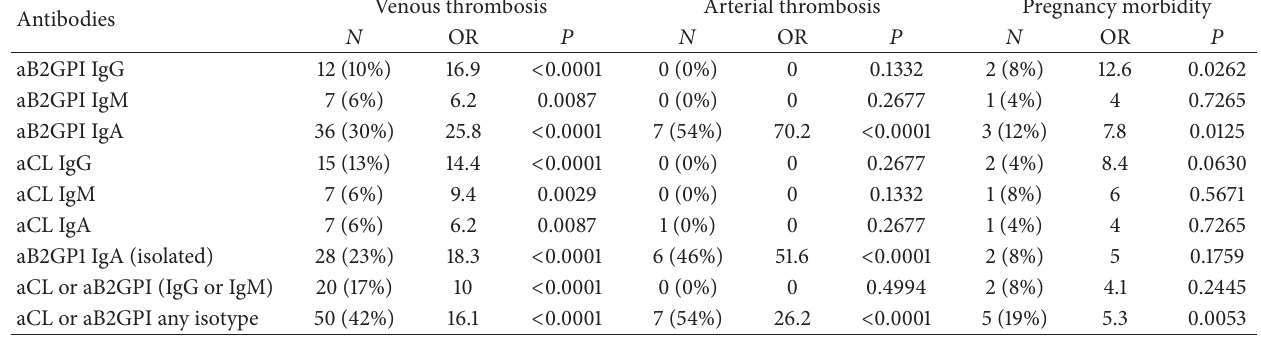
Table 5: APS morbidity and aPL autoantibodies.